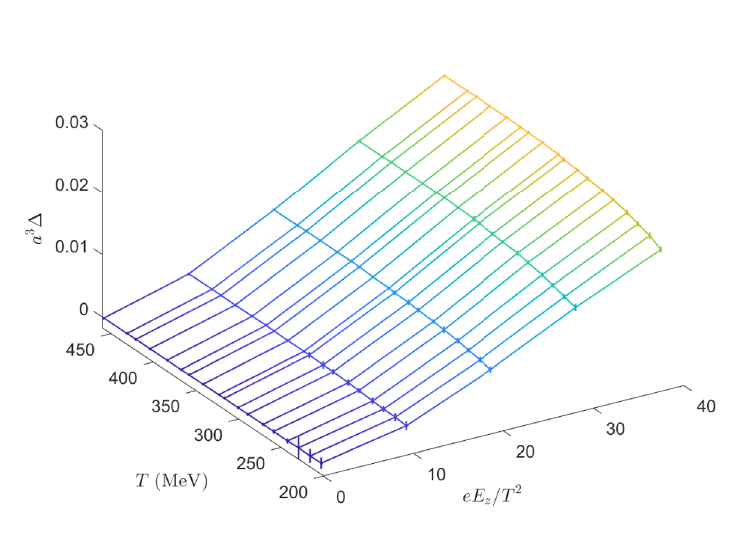
Figure 14 . ∆ = c u − c d as a function of T and eE z /T 2